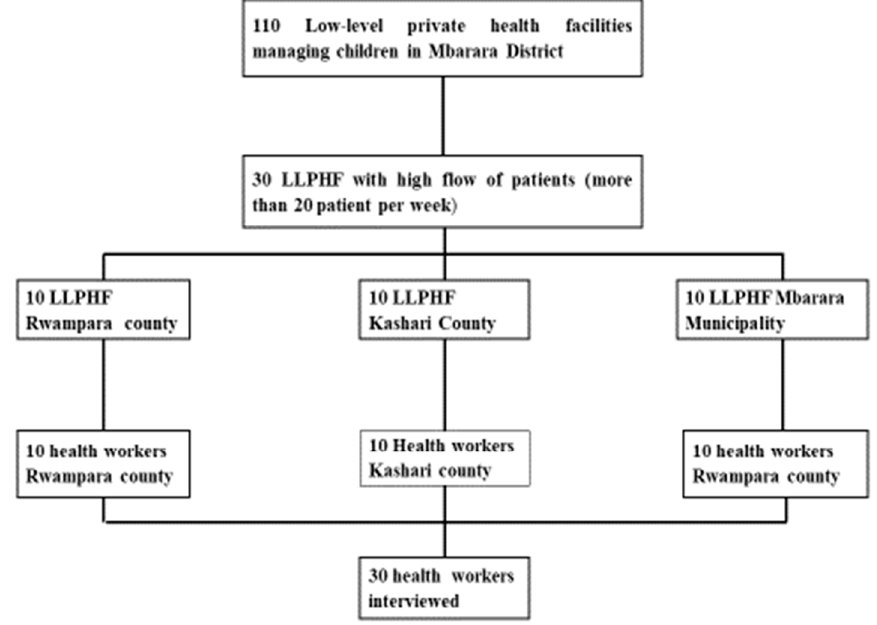
Figure 1. Flowchart for purposive sampling of health facility and healthcare worker participants for perspectives of HCW on the referral process from low-level health facilities in Mbarara District.